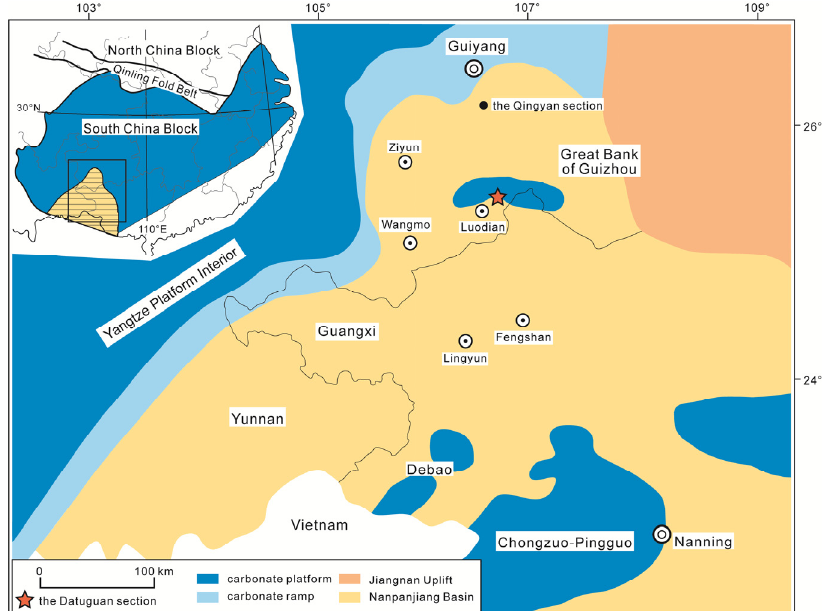
Figure 1. Early Triassic palaeogeographical map of Nanpanjiang Basin, South China (modified after [37]), showing the location of the Datuguan section and Qingyan section.